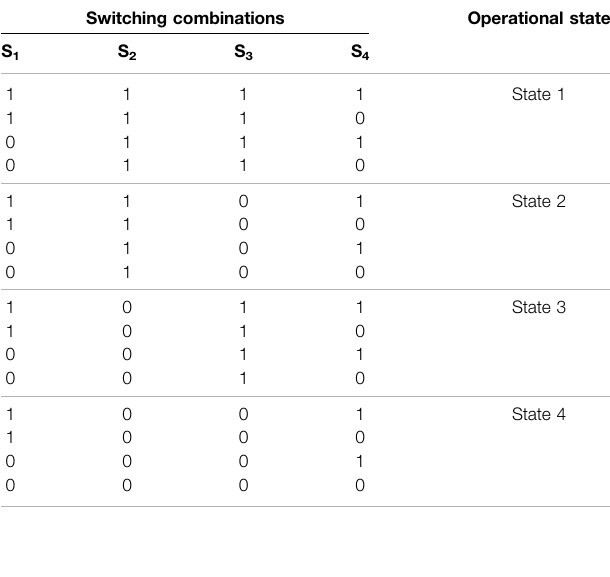
TABLE 1 | Main operational states of the proposed converter. Switching